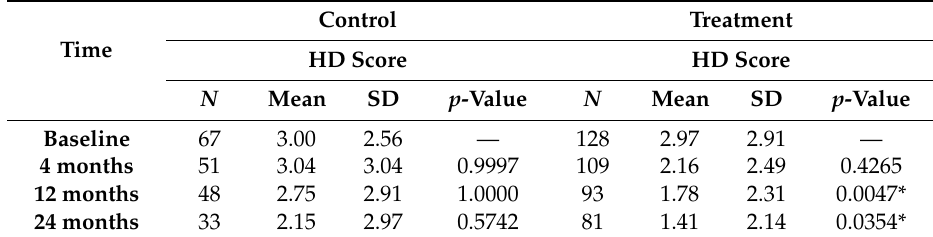
Table 2. HD scores among groups across time.